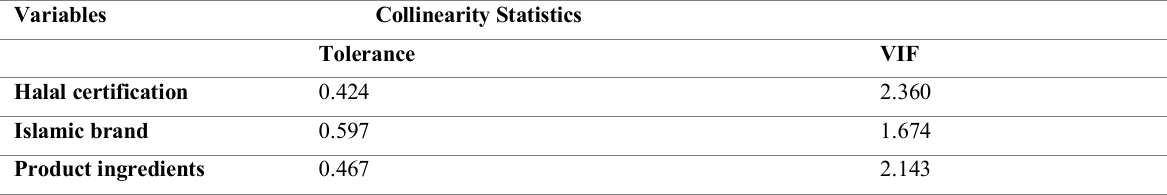
Table 7: Collinearity statistics of Indonesia